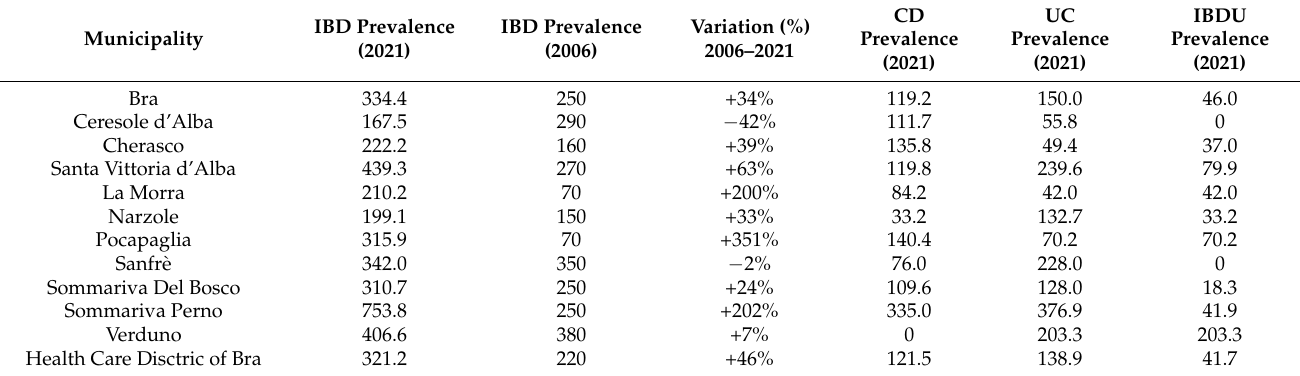
Table 2. IBD prevalence in the Healthcare District of Bra according to